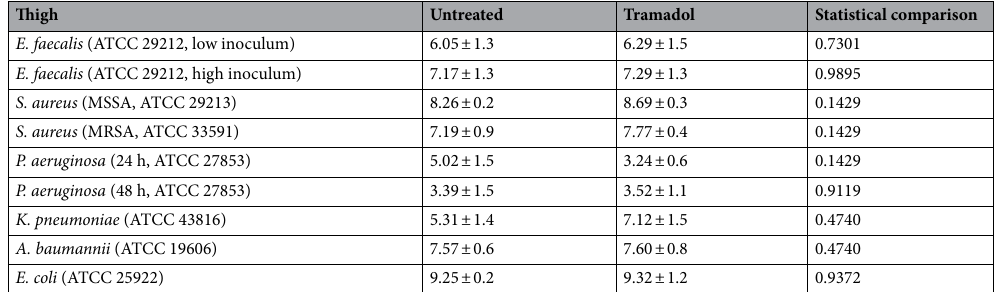
Thigh Untreated Tramadol Statistical